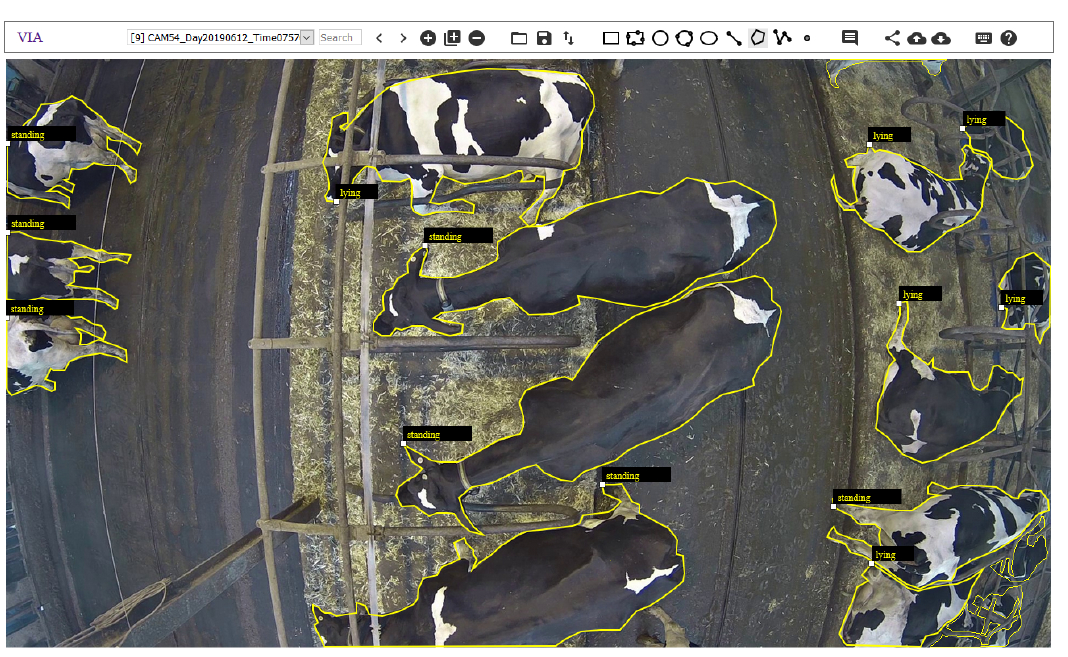
Figure 3. Example of an image that was manually annotated with VIA 3—apart from the outlines of the cows it was labelled if the animal was ‘standing’ or ‘lying’. The posture information has not yet been used for training the